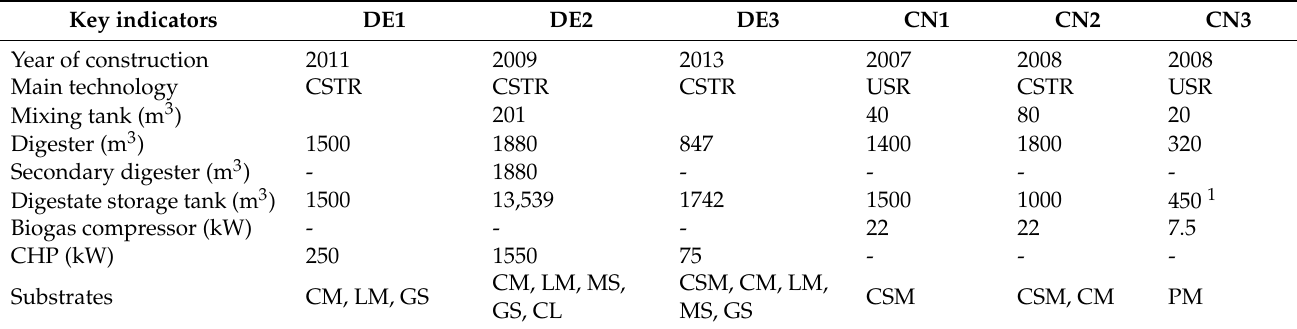
Table 1. Characteristics of the selected German (DE) and Chinese (CN) biogas